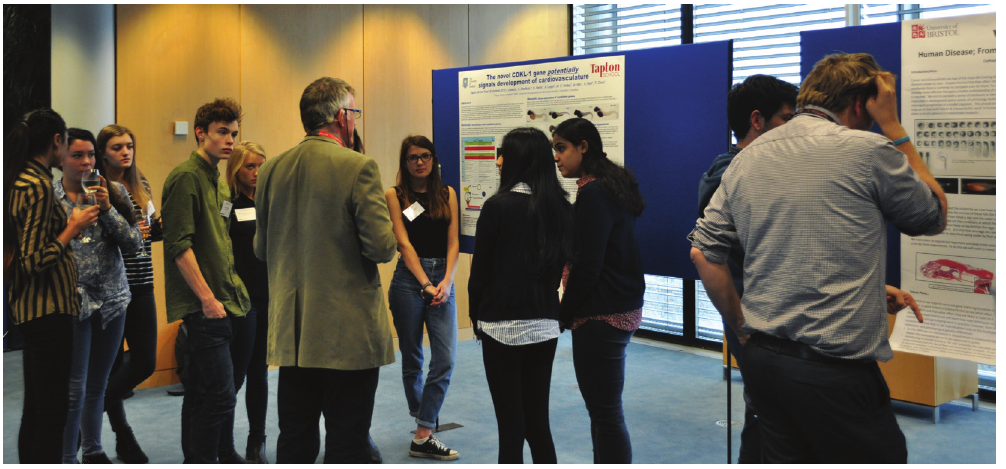
Figure 5: Poster session at the third Authentic Biology